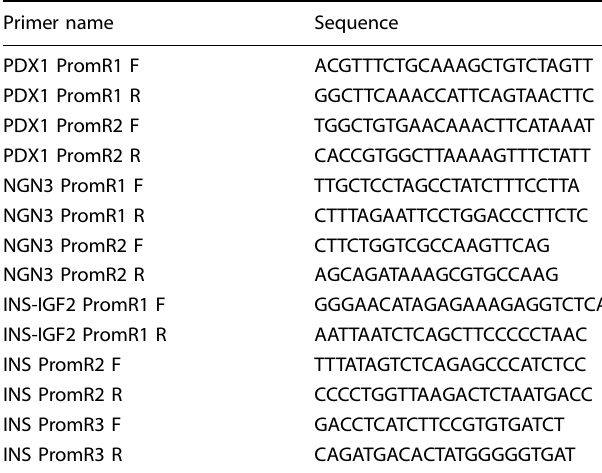
Table 3. Human primer sequences for